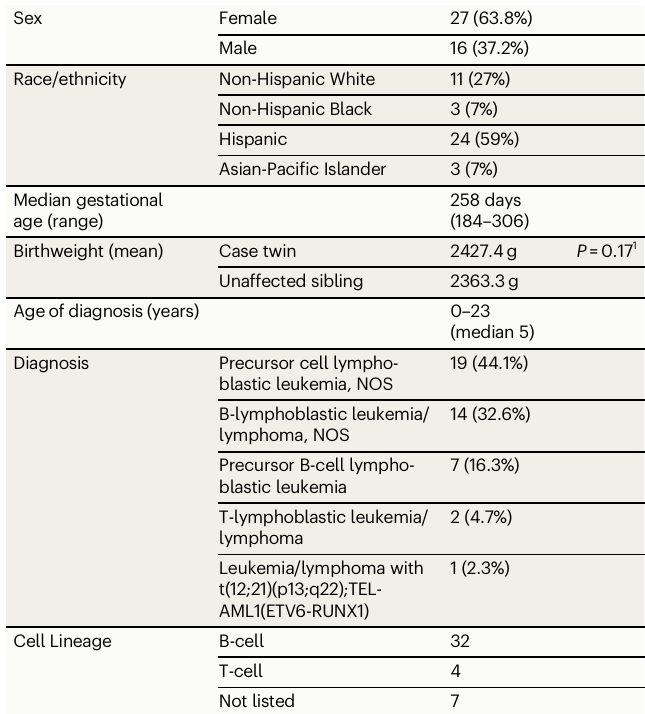
Table 1 | Subject